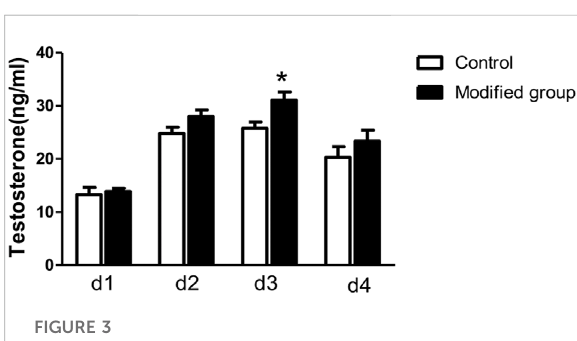
FIGURE 3 Testosterone production by cultured fetal testis ex vivo . *, signi fi cantly different from control at p <